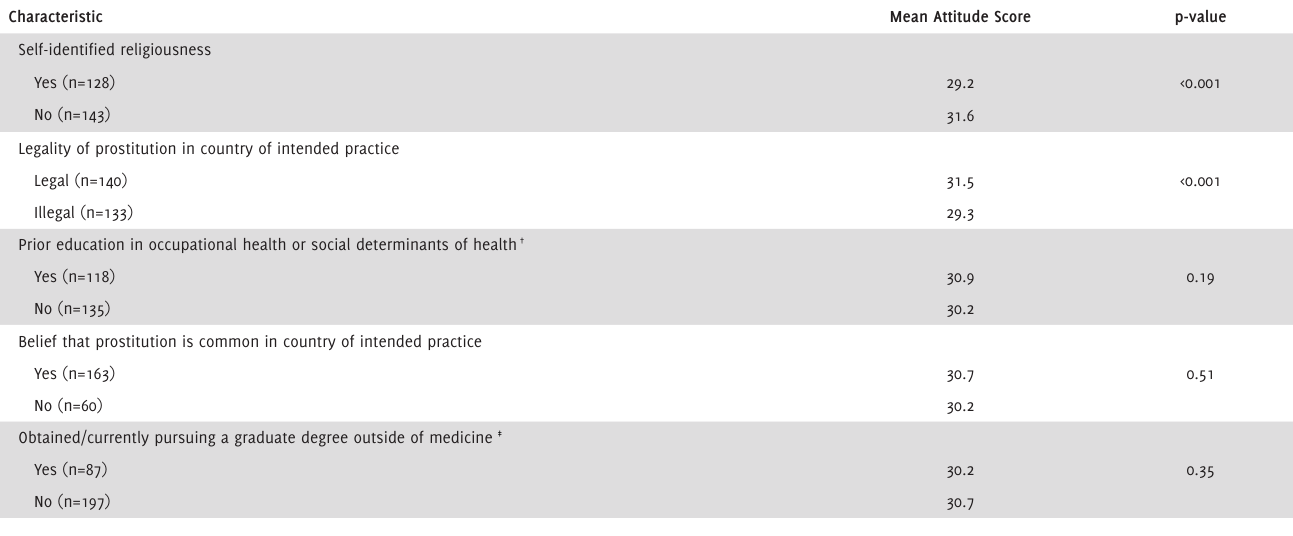
Table 2. Results of Two-sample T-Tests for Differences in Attitudes. +